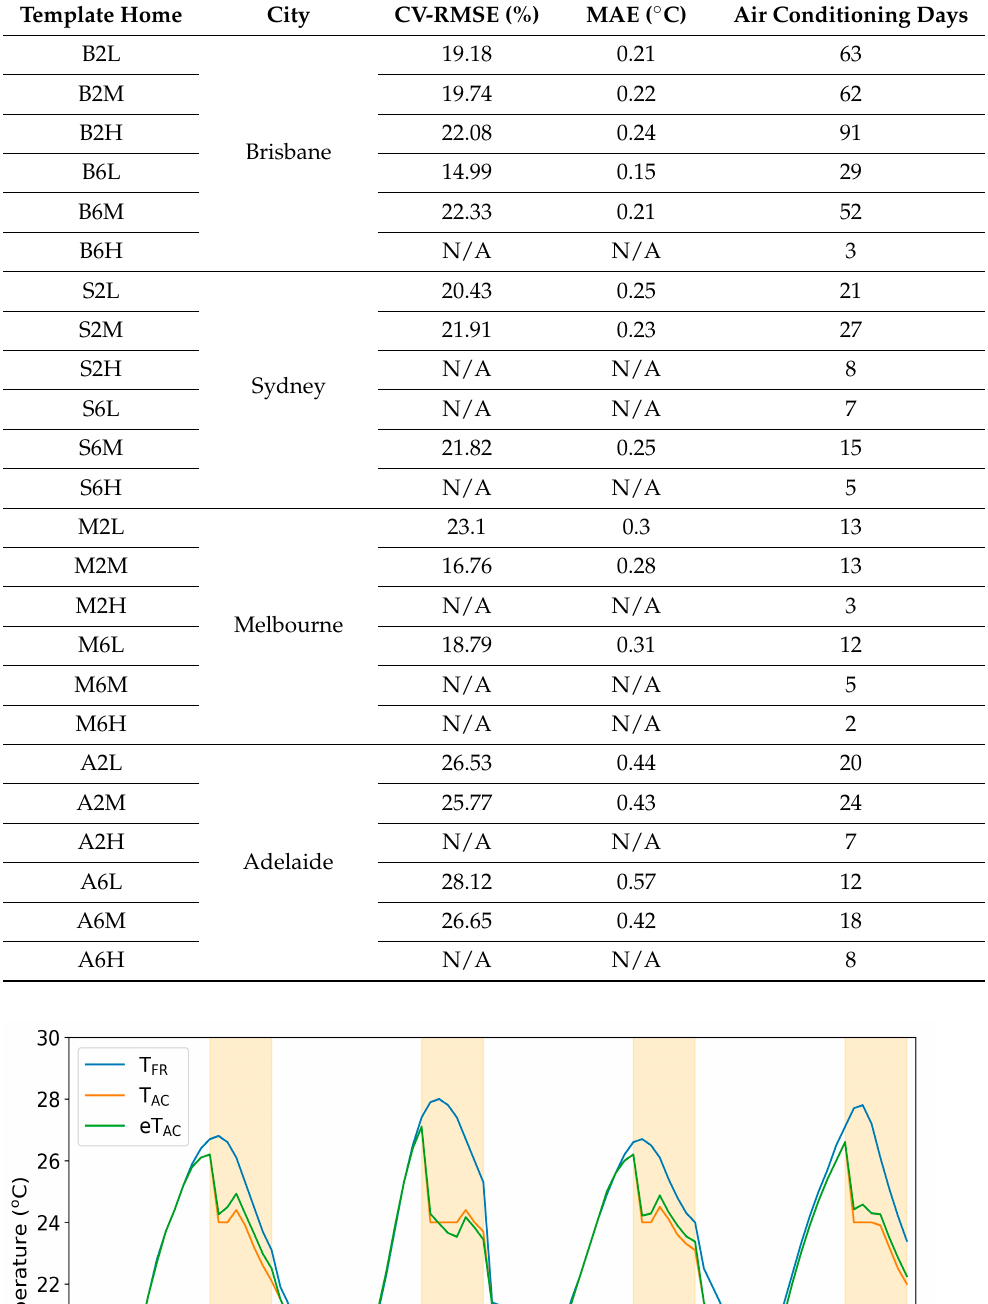
Table 2. CV-RMSE and MAE for 15 of 24 template homes.